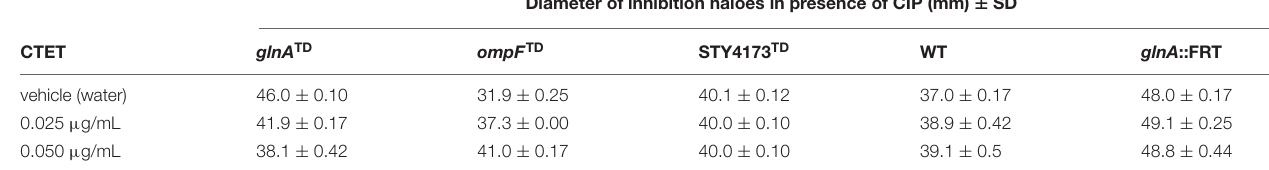
TABLE 3 | Induction of glnA in glnA TD mutant decreases the susceptibility to ciprofloxacin (CIP). Diameter of inhibition haloes in presence of CIP (mm) ± SD